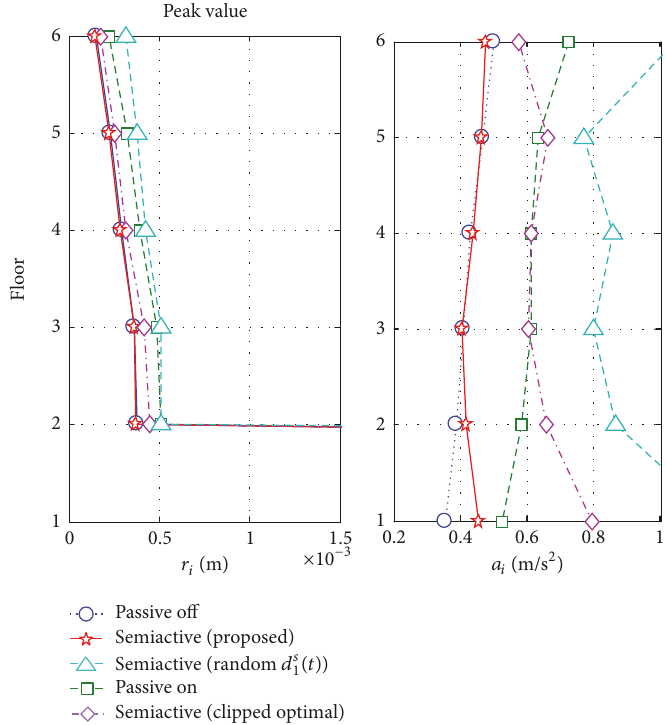
Figure 17: Simulation results for the Kobe NS (1995) earthquake disturbance; peak values of the relative displacement between neighboring floors and absolute acceleration of each